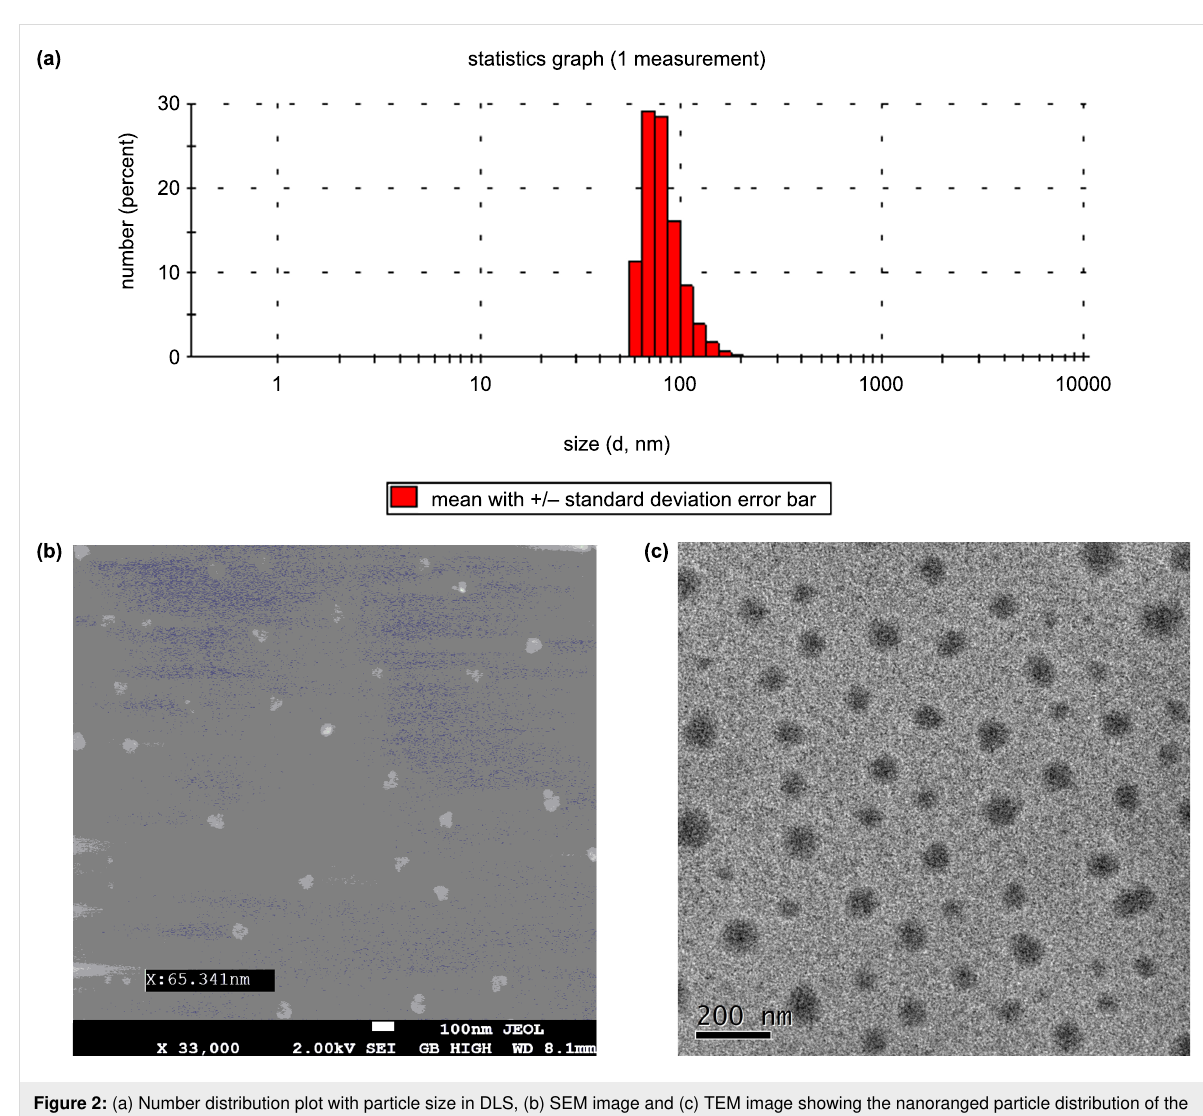
Figure 2: (a) Number distribution plot with particle size in DLS, (b) SEM image and (c) TEM image showing the nanoranged particle distribution of the macrocycle.